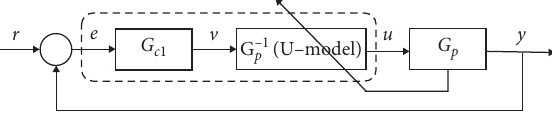
Figure 2: U-control system